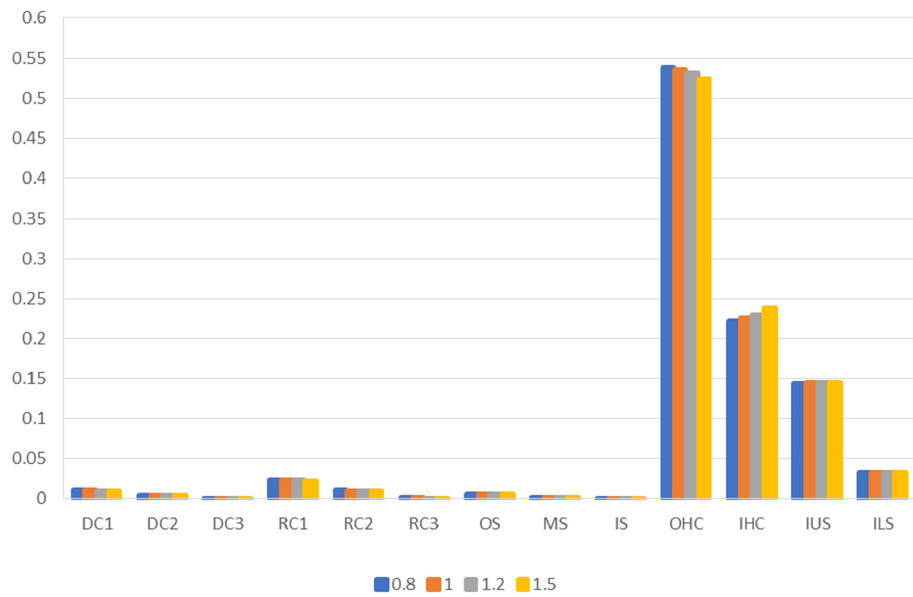
Figure 7. Importance coefficients of different elements under different cross-sectional areas of the elements.